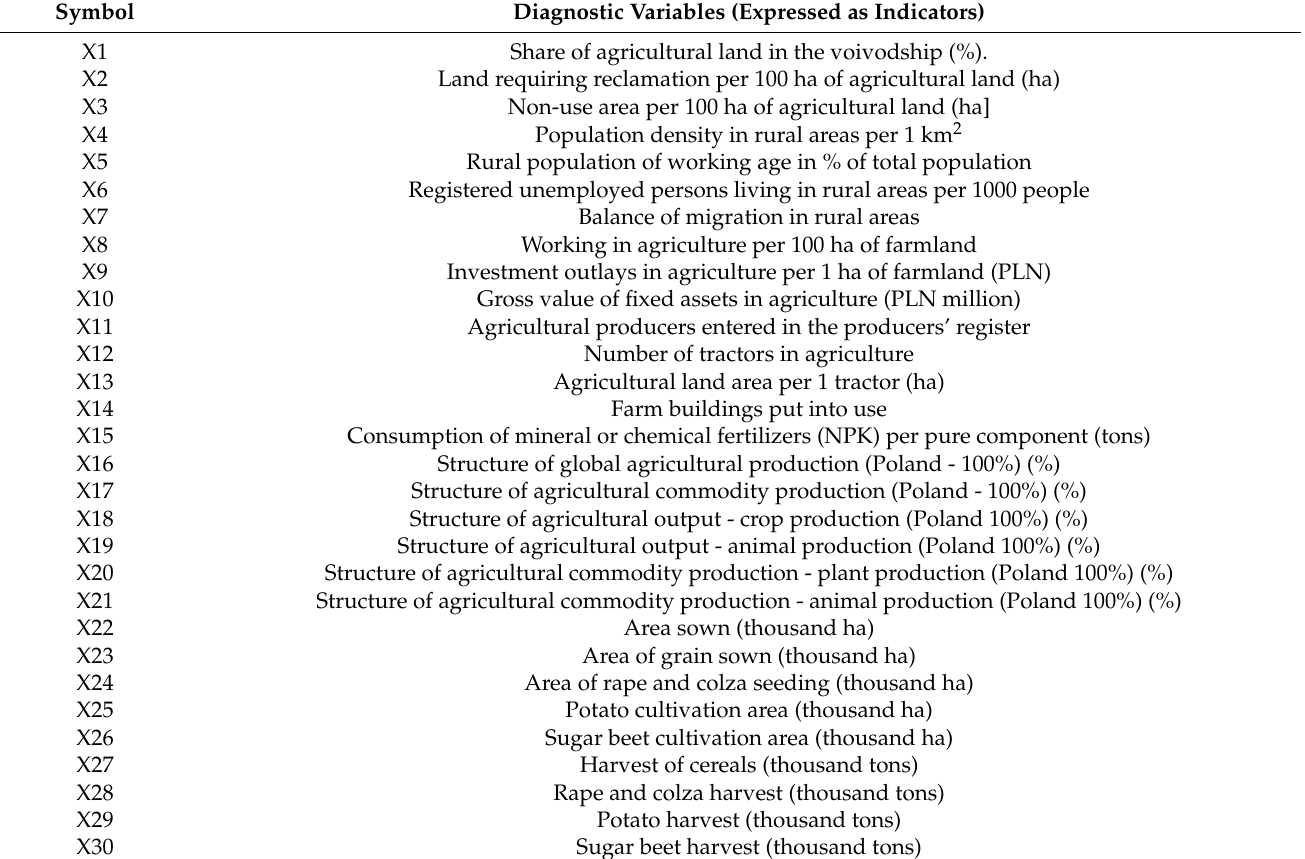
Table 1. Diagnostic variables used in the